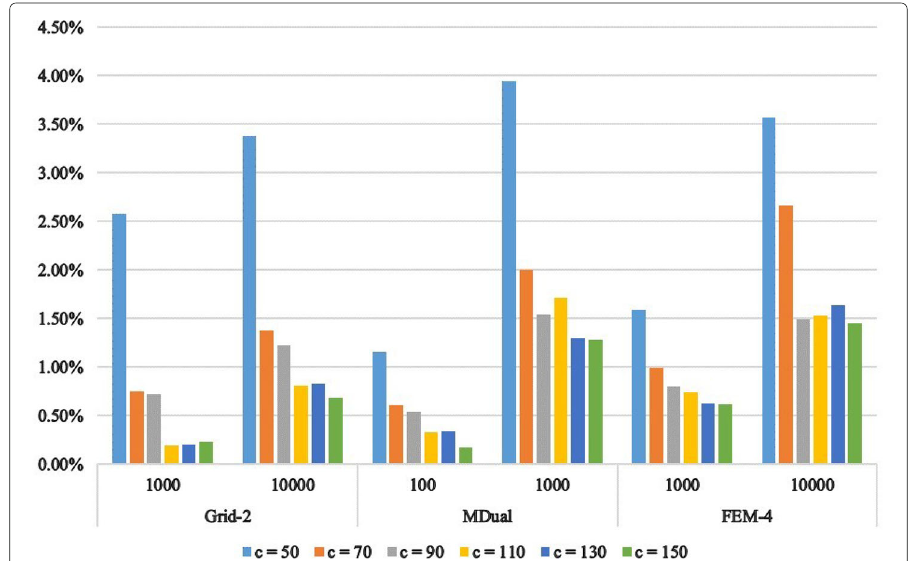
Fig. 5 The unbalanced ratios with different contracted parameters